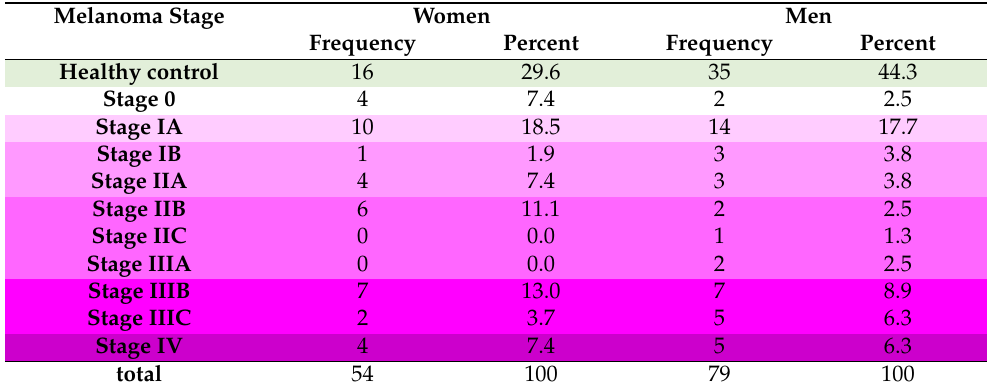
Table 1. Composition of respondents by gender in individual categories based on melanoma stage. Melanoma